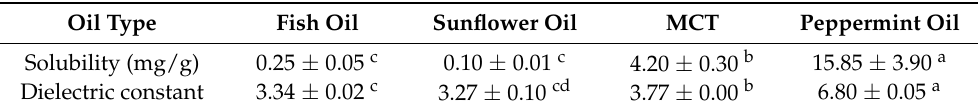
Table 1. Solubility of resveratrol in sunflower, fish and peppermint oils and medium-chain triglyc- eride (MCT) and dielectric constant of the